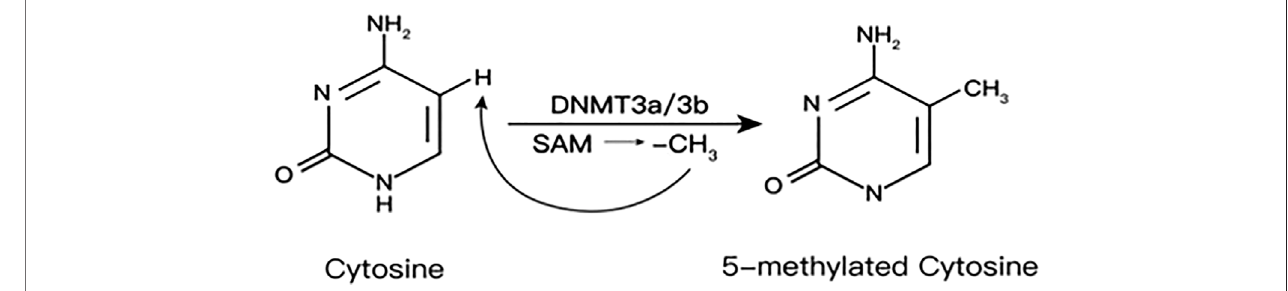
FIGURE 2 | Mechanism of DNA methylation in the pathogenesis of atherosclerosis